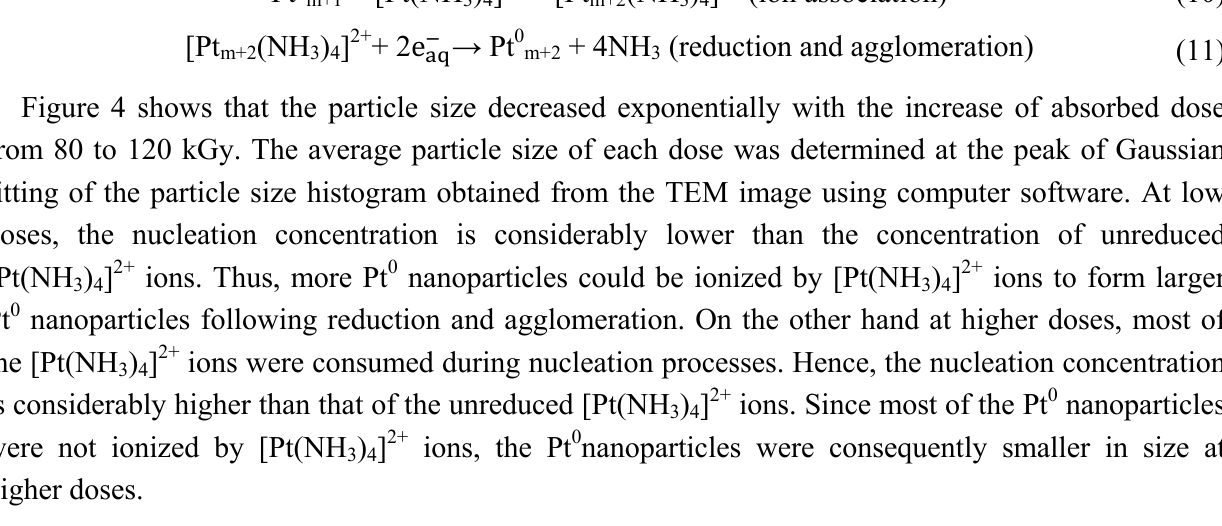
Figure 4. Average particle size of Pt nanoparticles was decreasing exponentially with increasing